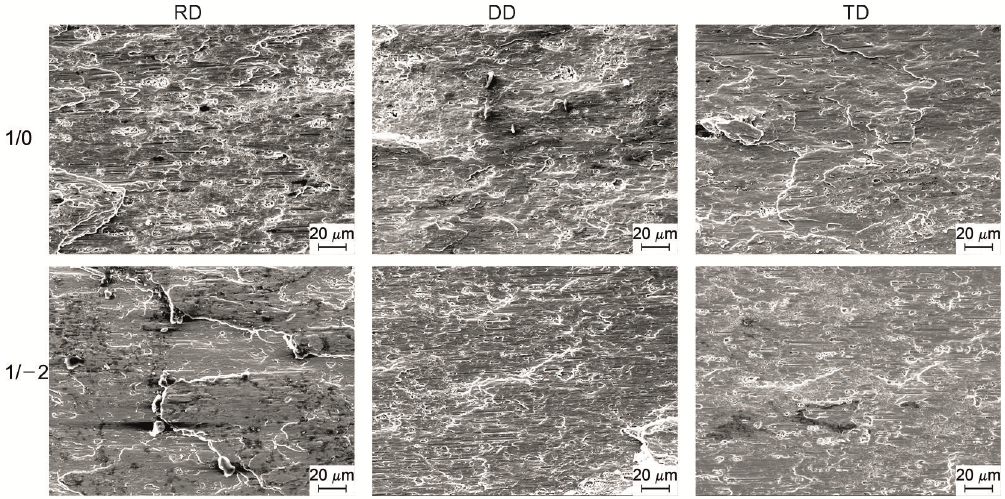
Figure 8. Scanning electron microscopy of fractured specimen surfaces.